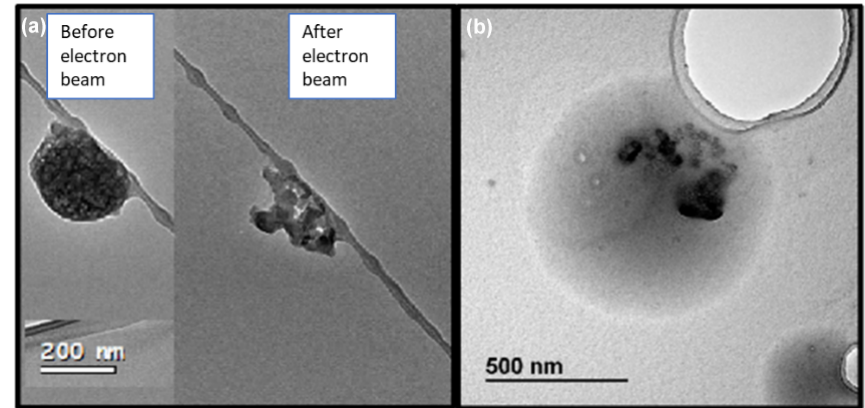
Figure 4. Potassium salt in a core–shell morphology around a refractory BC core (a) and organic aerosol with interstitial K salt (b) . Note the difference in scale between the two images.